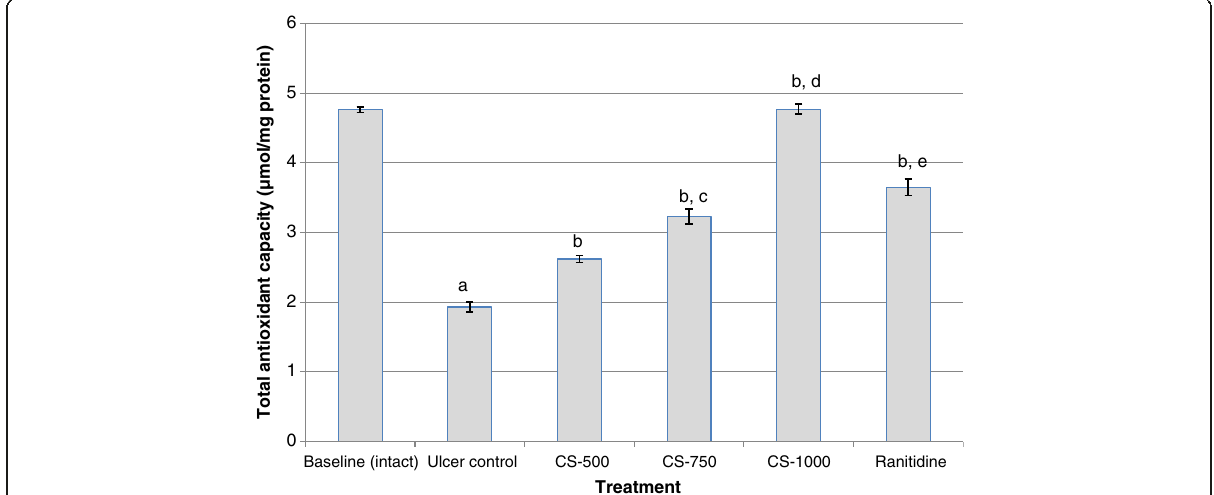
Figure 2 Effect of C. sieberiana (CS) plant extract on serum total anti-oxidant capacity in F 344 rats. a p<0.001 compared with baseline (intact); b p<0.001 compared with ulcer control; c p<0.05 compared with CS-500; d p<0.001 compared with CS-750; e p<0.01 compared with CS-1000; Values are Mean ± SEM of 6 animals. Statistical significance was determined by one-way analysis of variance (ANOVA) followed by Dunnett ’ s post hoc t